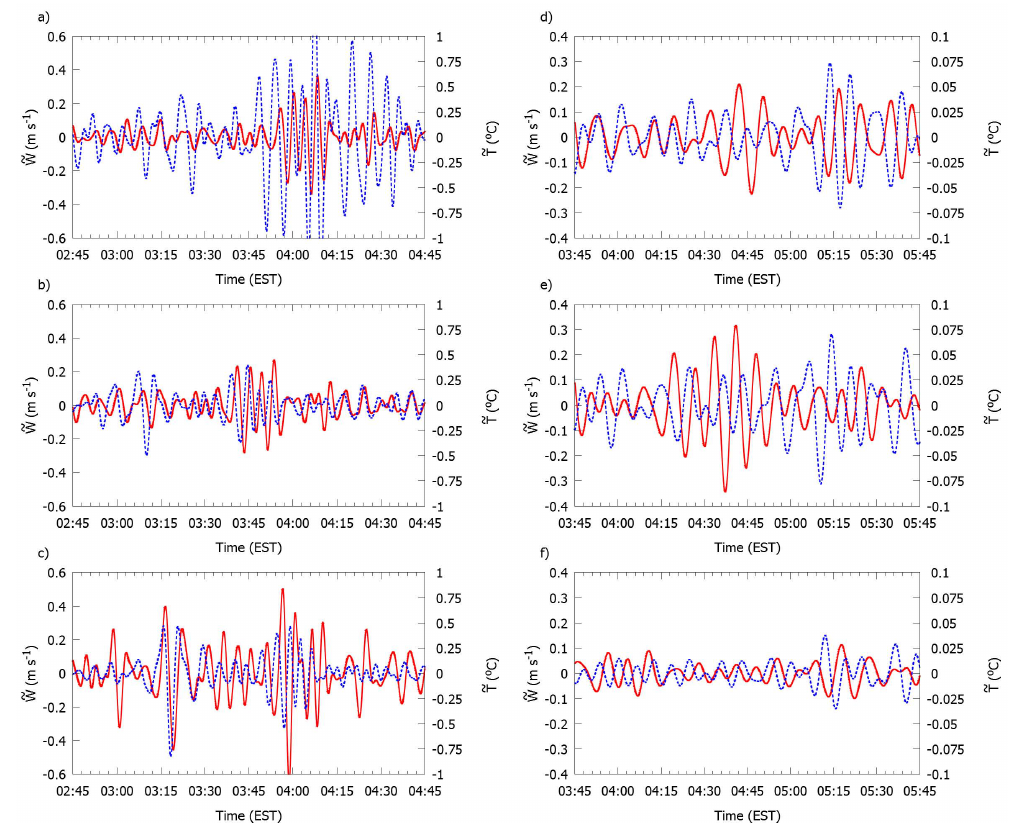
Fig. 3. ˜ w (solid) and ˜ T (dashed) at 34 (a, d) , 68 (b, e) , and 329m (c, f) for 23 April 2009 and 3 December